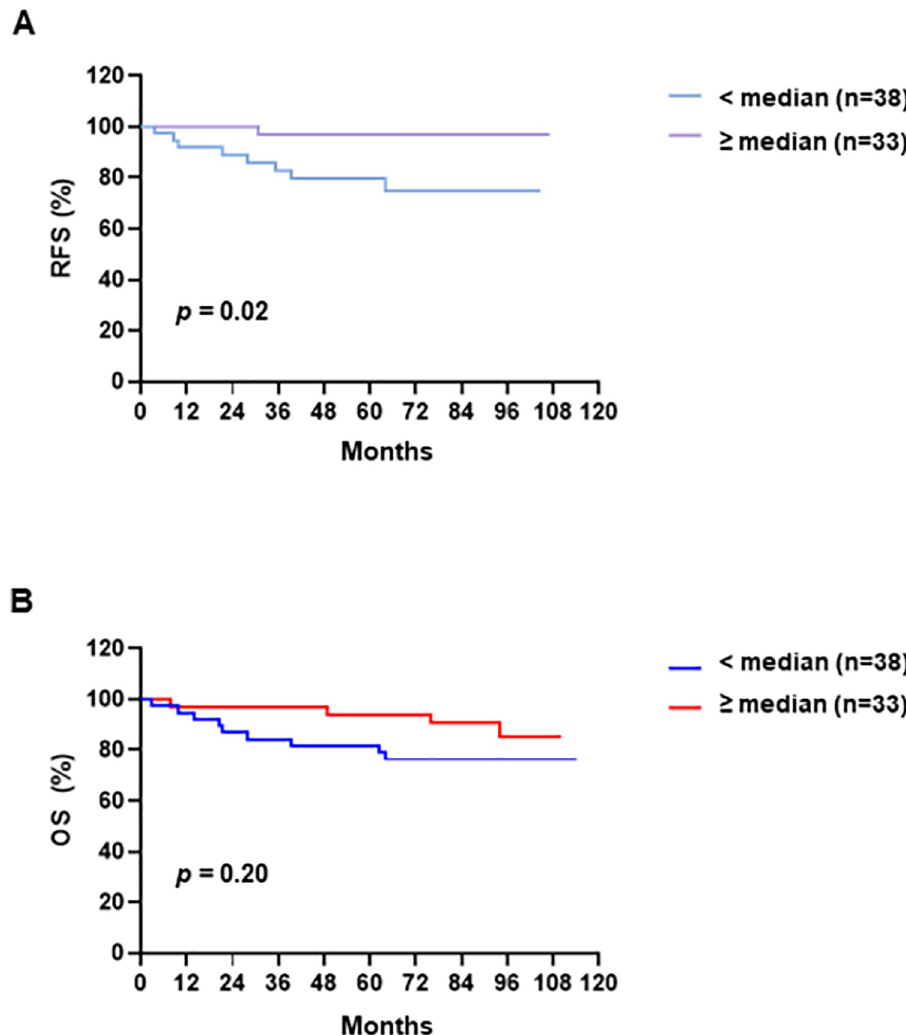
Fig 5. Kaplan-Meier analyses of OPSCC stratified by Treg proportion in the tumor region. (A) Relapse-free survival (RFS) and (B) overall survival (OS) in patients with OPSCC stratified by Treg cells in the tumor region. RFS and OS in relation to low ( < median) or high frequencies ( � median) of Treg cells were plotted by Kaplan-Meier survival curves. Statistical significance was determined by log-rank (Mantel-Cox) regression analysis.